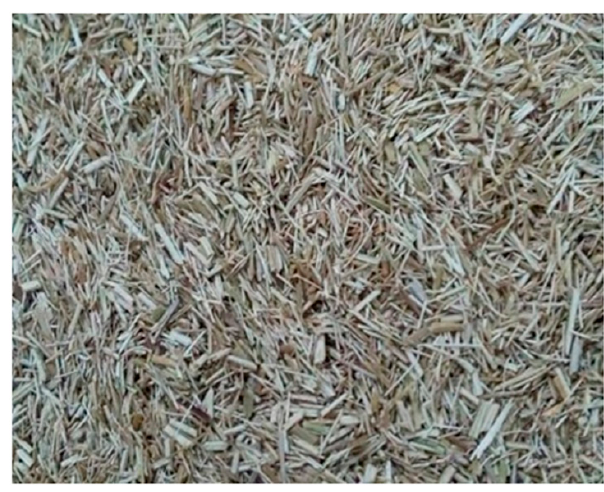
Figure2. Crushed fibers. Figure 2. Crushed